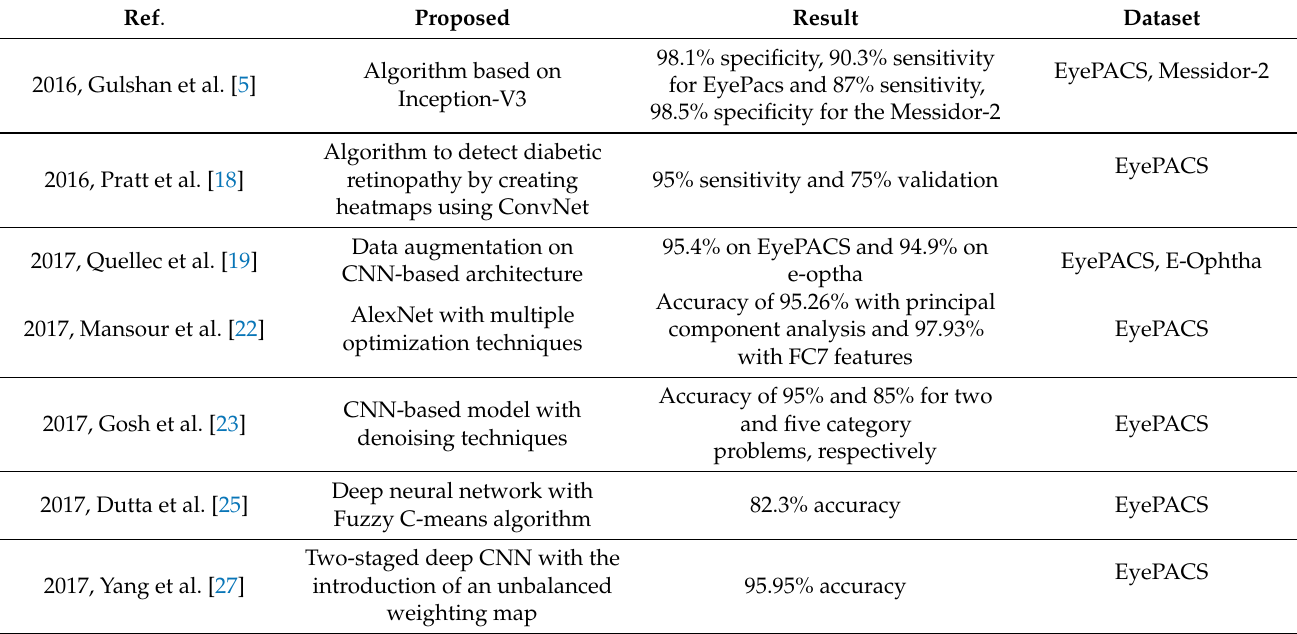
Table 1. Summary of related